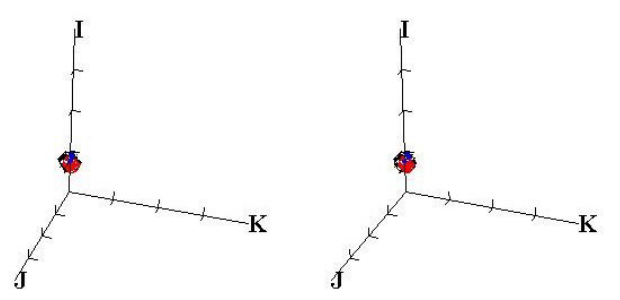
Figure 3 Stereo-pair scatter plot (with included 95% distribution ellipsoids) of R1: 50 auto-keratometric measurements taken before (black data points) and R2: 50 auto-keratometric measurements taken after (red data points) three hours of RGP contact lens wear. The origin of the scatter plot is 42.50 I